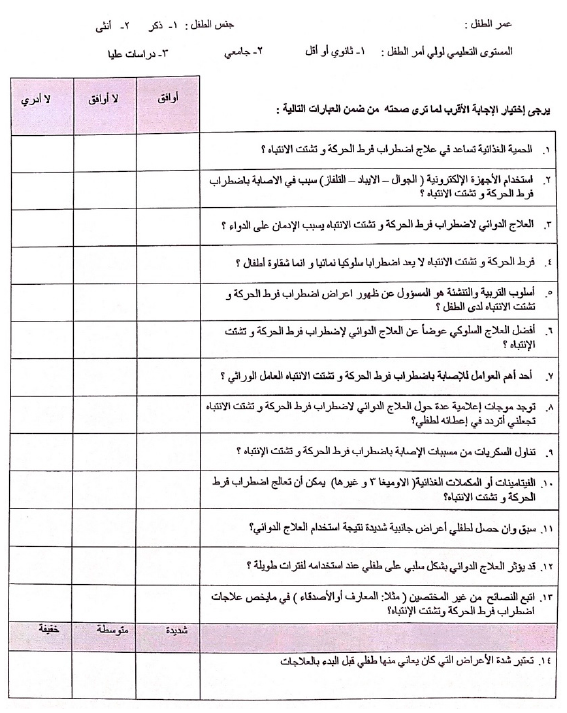
Figure A1. Arabic version of the questionnaire.